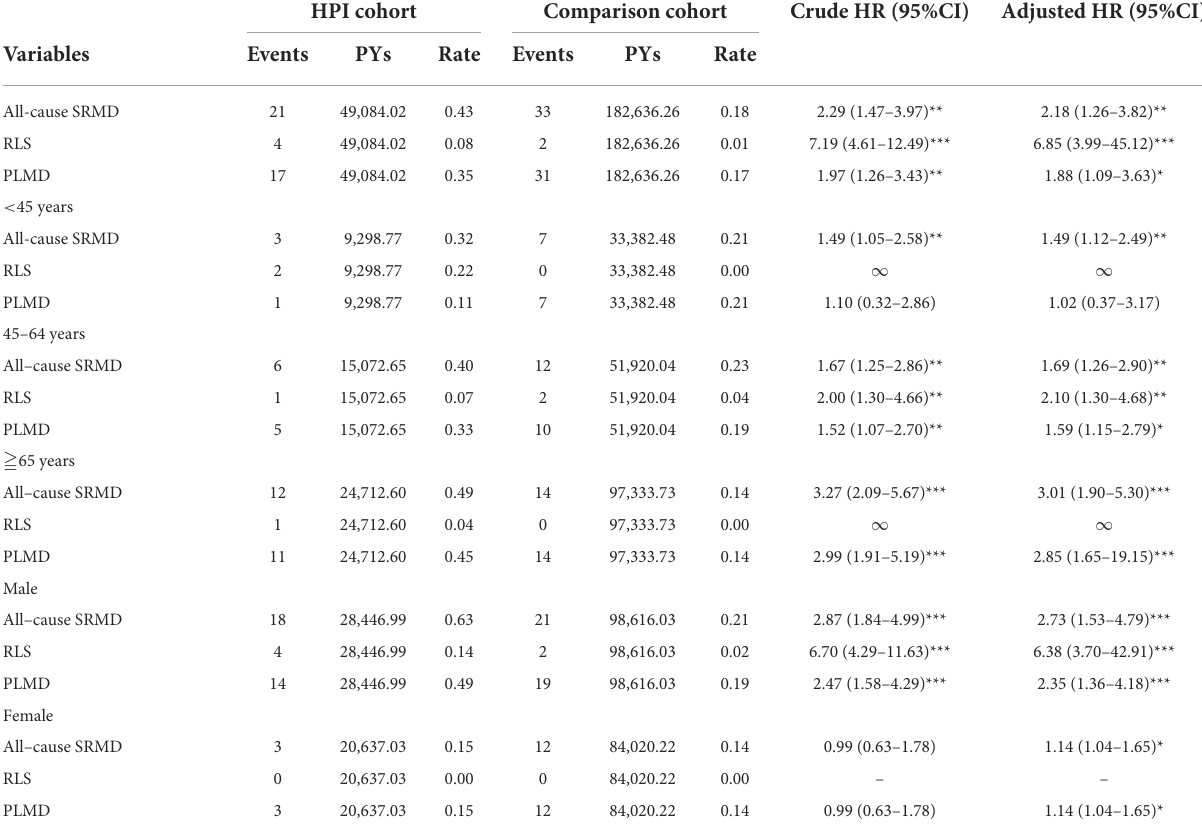
TABLE 2 Factors of SRMD subgroup stratified by age group or gender for Cox regression